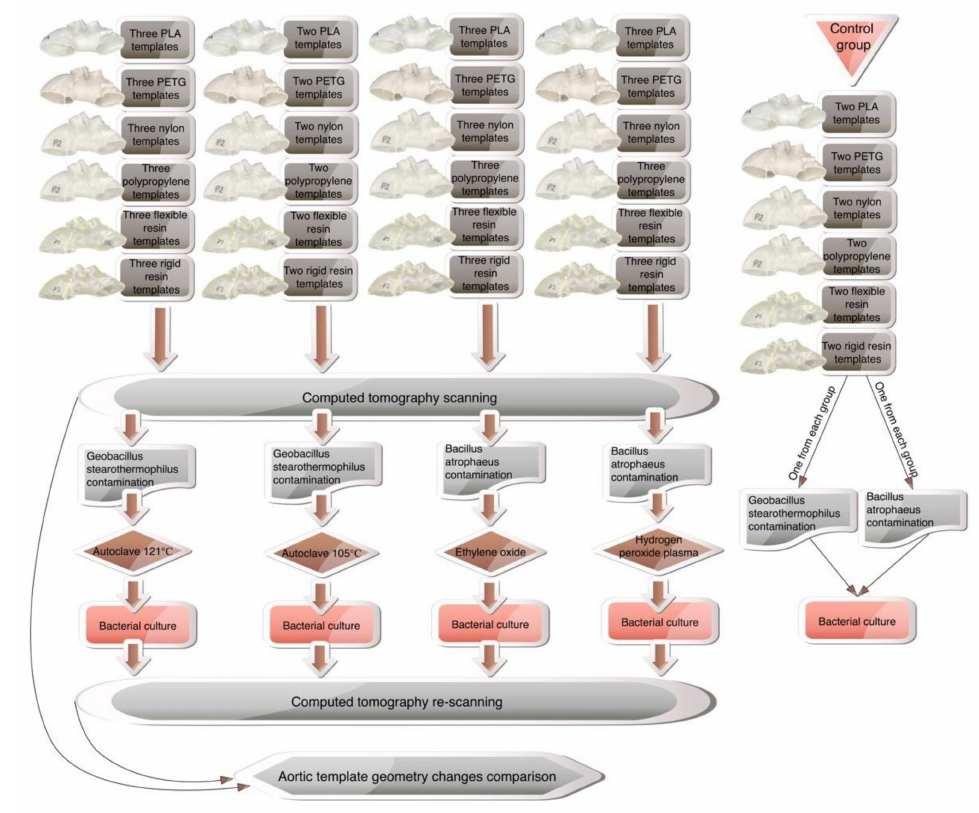
Figure 5. The methodology